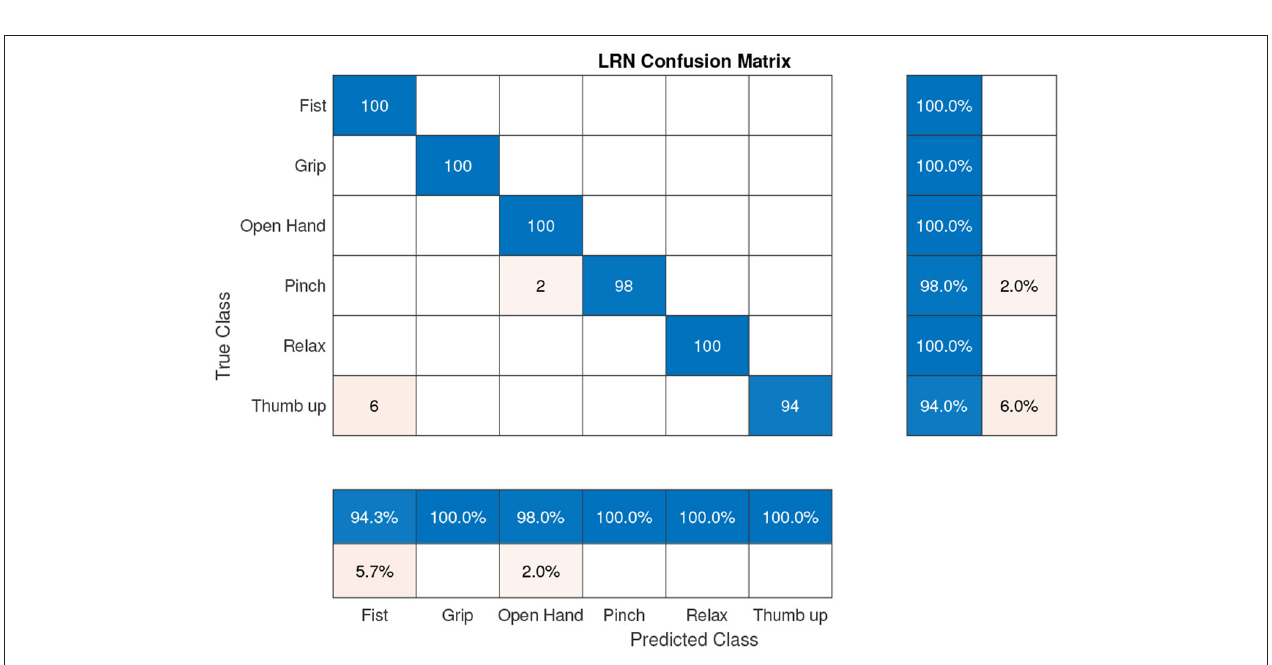
FIGURE 9 | Online LRN confusion matrix (accuracy